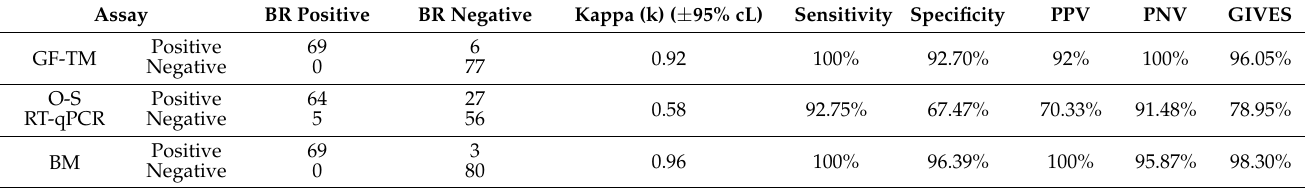
Table 2. Comparison of results between the four molecular assays for the detection of SARS-CoV-2 using the Berlin protocol (BR) as a reference (n = 152, of which 62 were positive and 83 were negative).